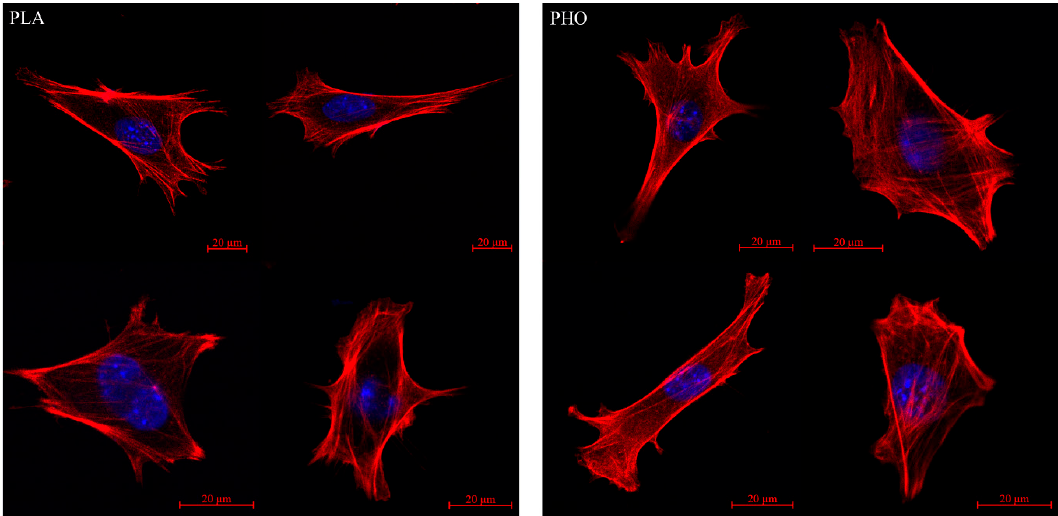
Figure 4. Exemplary microscopic images showing the structure of actin fibers in cells cultured on PLA ( left ) and PHO ( right ) substrates.